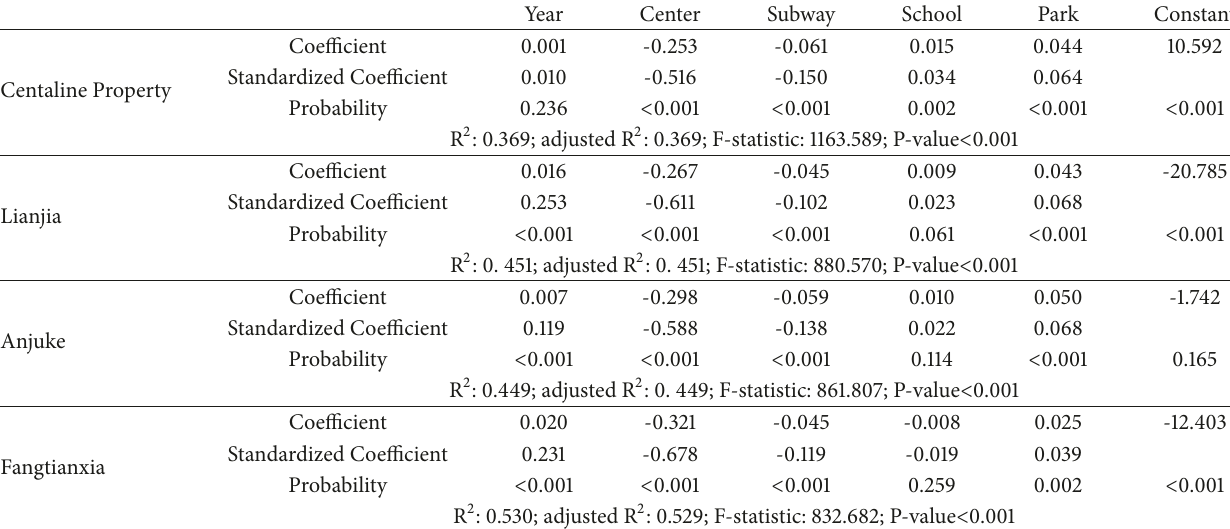
Figure 6: Spatial interpolation of variation for corresponding second-hand neighbourhoods’ housing prices on each website. Table 5: Results and evaluation of hedonic housing price